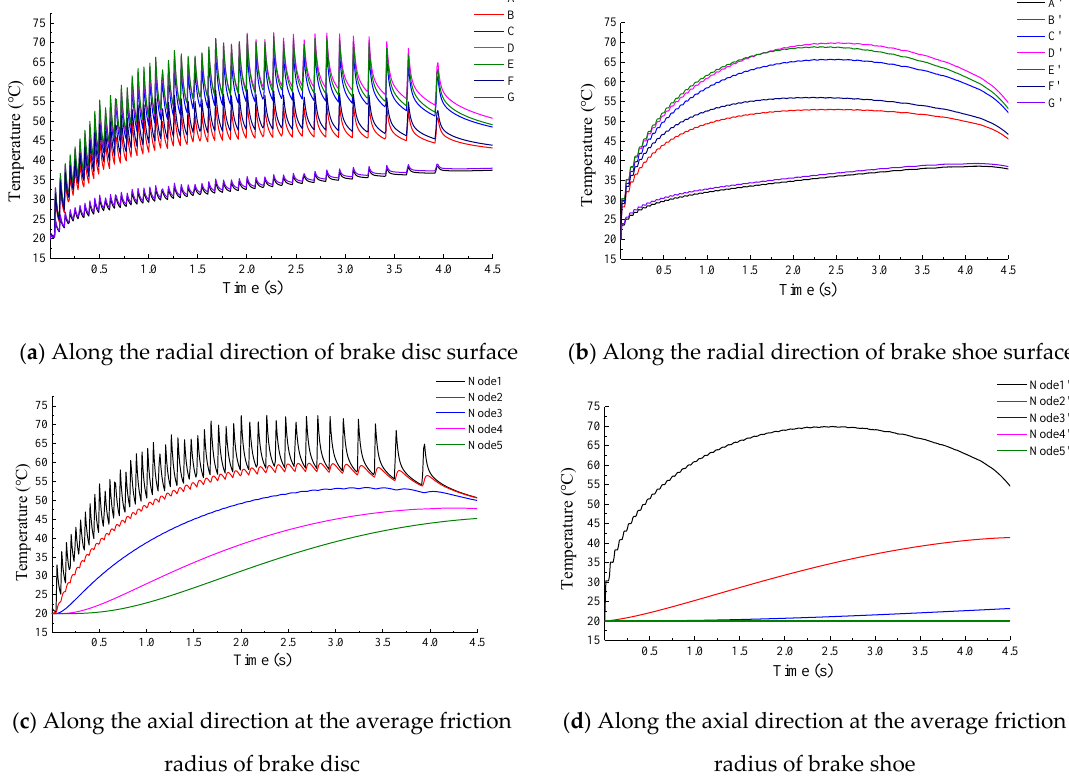
( c ) Along the axial direction at the average friction ( d ) Along the axial direction at the average friction radius of brake disc radius of brake shoe Figure 8. Temperature distributions along radial and axial paths of brake disc and brake shoe during emergency braking.